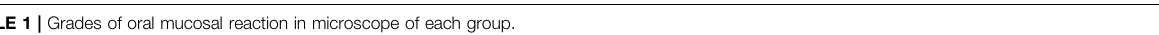
TABLE 1 | Grades of oral mucosal reaction in microscope of each group. Group